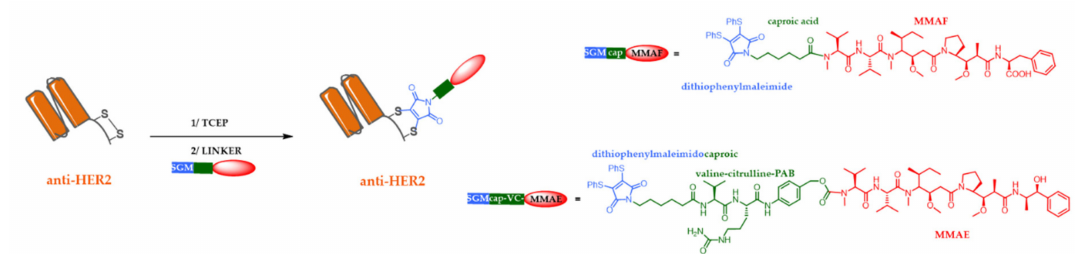
Figure 5. Homogeneous SDC (scFv-drug conjugate) with a DAR 1 obtained by reduction (TCEP) of the C-terminal intrachain disulfide bridge followed by a site-specific bioconjugation reaction via a dithiophenylmaleimide linker